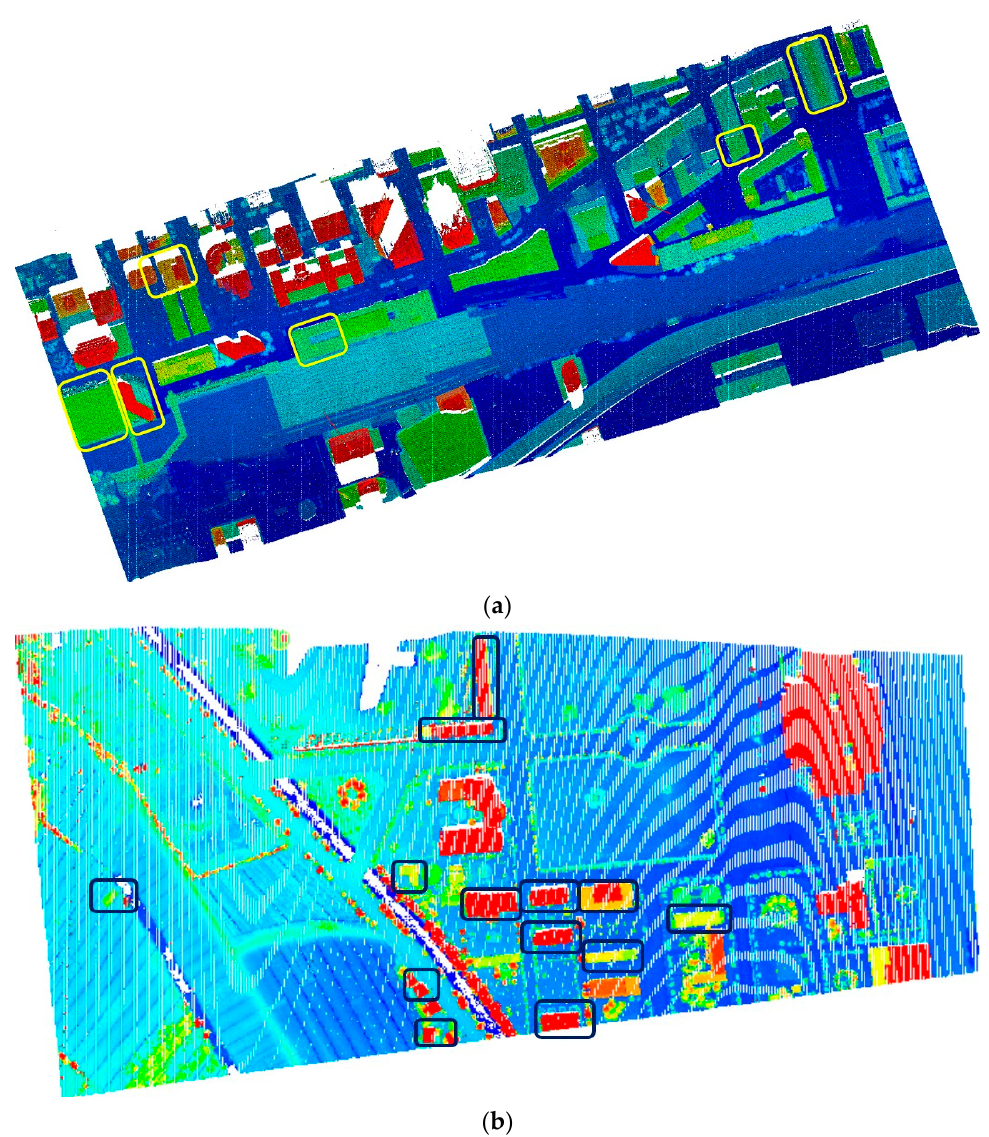
Figure 4. Spatial distributions of the selected buildings. ( a ) Selected buildings of first case; and ( b ) selected buildings for the second case.